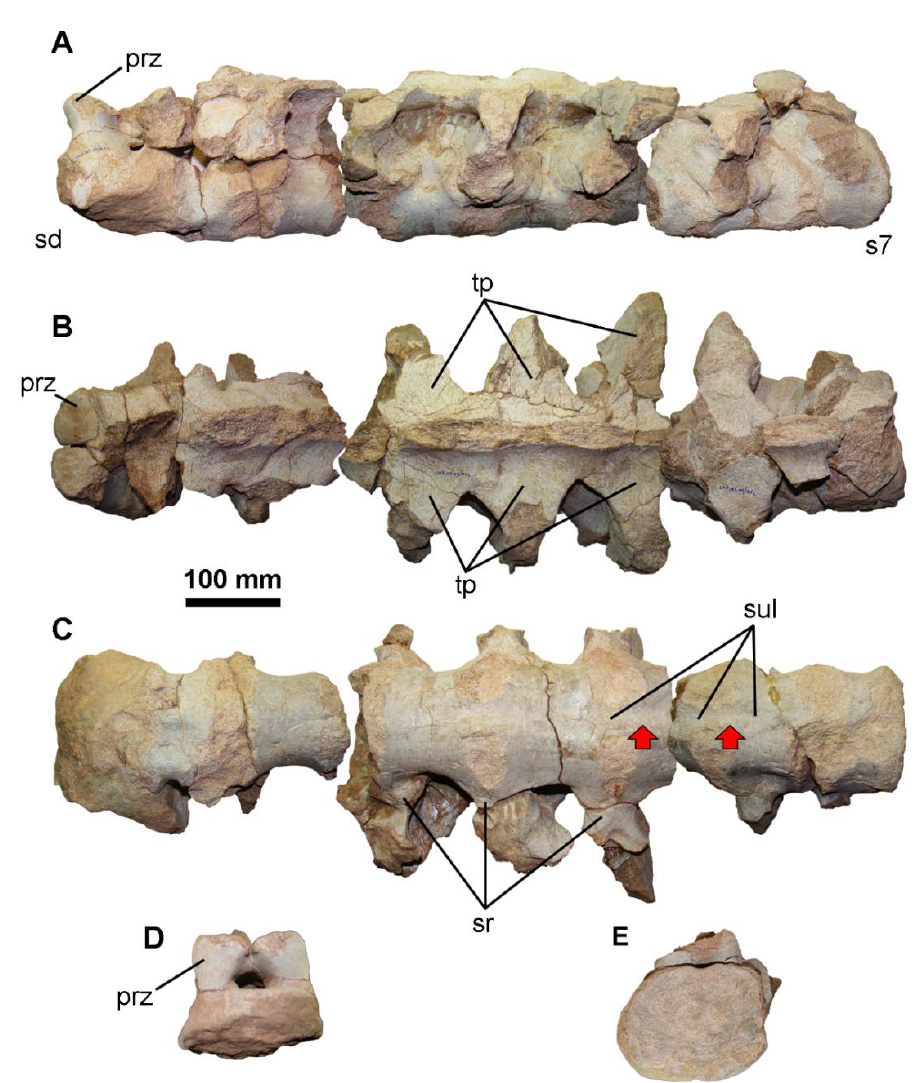
Figure 3. Sacrum of the specimen CMP-MS-04. CMP-MS-04/01 in left lateral ( A ), dorsal, ( B ), ventral ( C ), anterior ( D ), and posterior ( E ) views. Abbreviations: prz, prezygapophysis; sd, sacrodorsal vertebra; sr, sacral ribs; sul, midline sulcus; s7, sacral vertebra 7; tp, transverse process. Red arrows mark the distinctive character that assigned the specimen CMP-MS-04 to Iguanodon bernissartensis . 3.2.3. Caudal